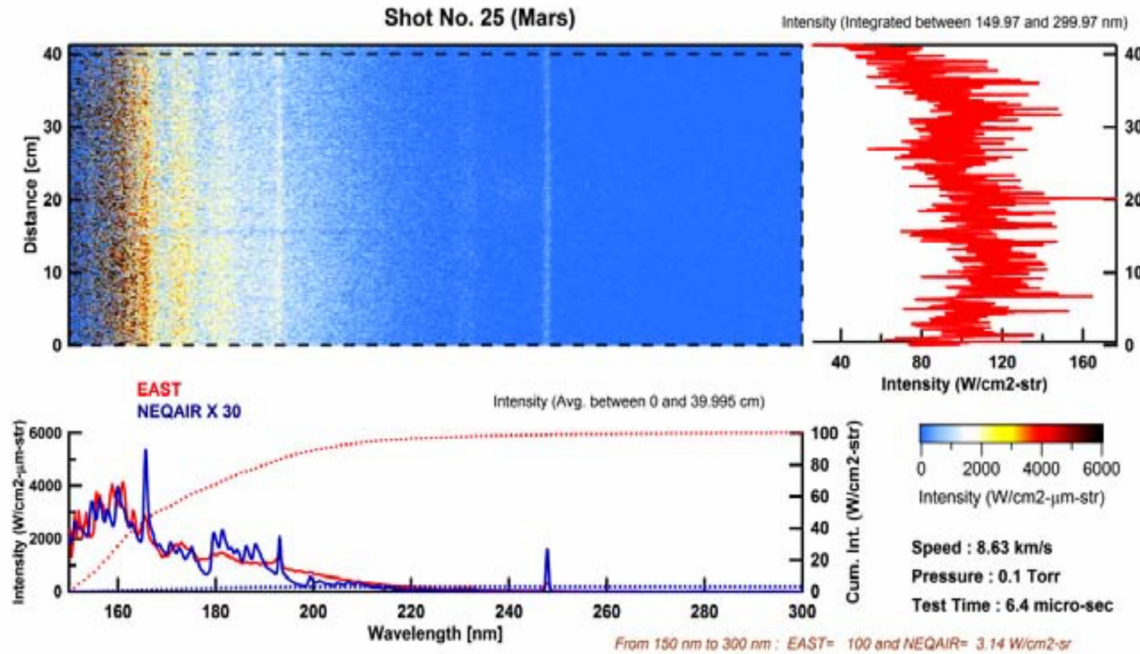
Figure 22. Comparison between NEQAIR calculations and EAST data in the VUV range at 0.1 Torr and a shock velocity of 8.63 km/s. The dotted curves are the cumulated intensity: measured in red and computed in blue (from